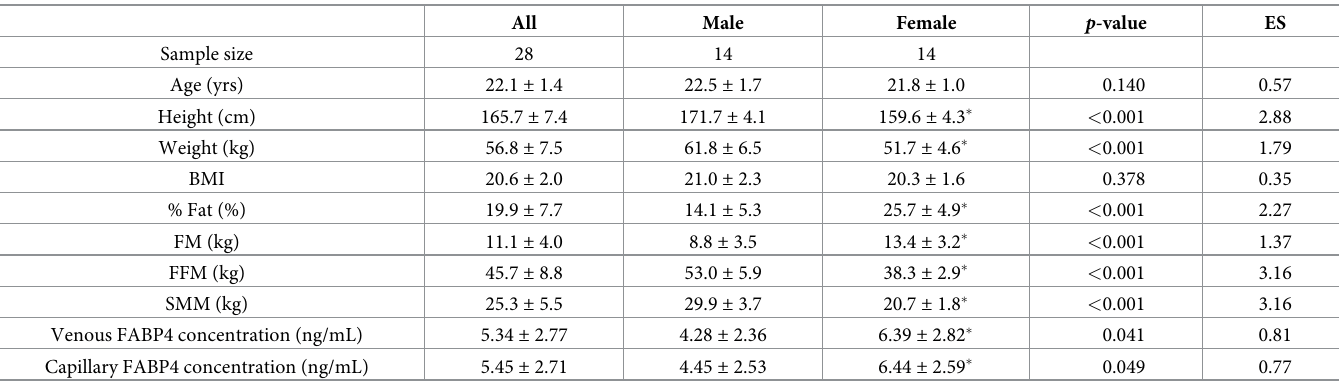
Table 1. Physical characteristics of all participants.